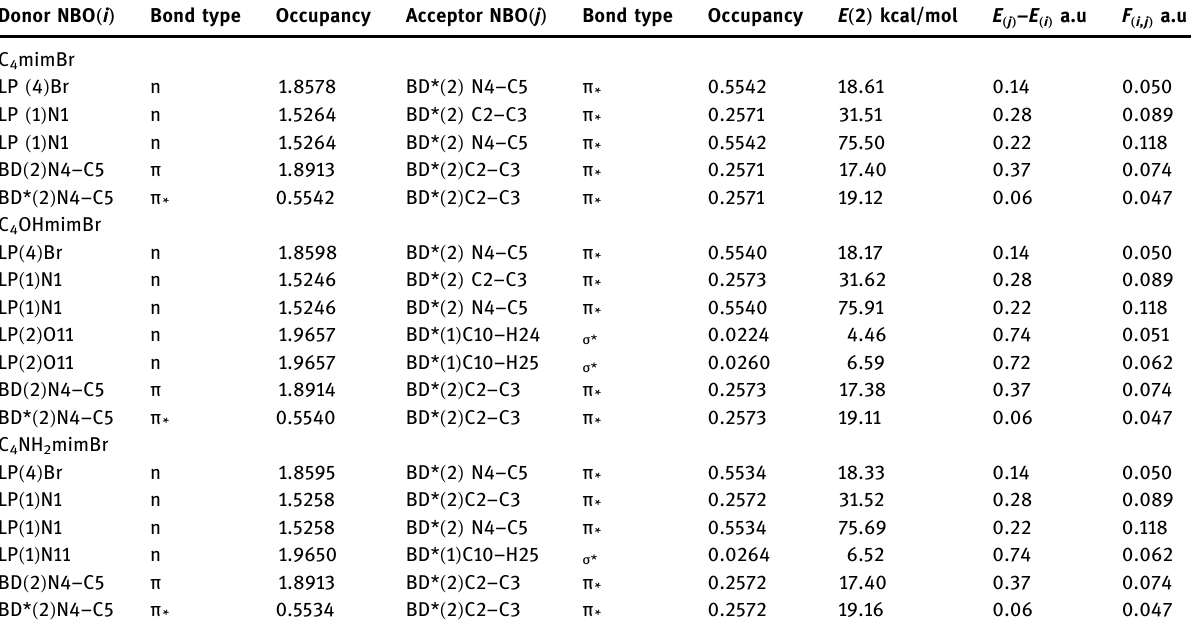
Table 4: The major interactions and the stabilization energies at the B3LYP/6 - 311 ++ G ( d, p ) level Donor NBO ( i